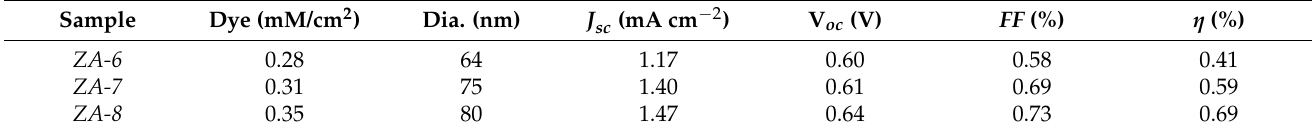
Figure 6. J-V characteristic curves of hexagonal MMO nanorods DSSC. Table 2. In-depth XRD parameters of the prepared Zn(Al)O-MMO Nanorods (ℎ𝑘𝑙 = 101) .